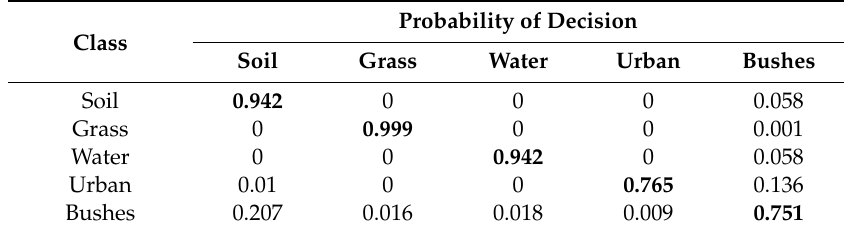
Table 19. Classification probabilities (confusion matrix) for the NN-based method trained for the original image and applied to the compressed image (PSNR-HVS-M = 42